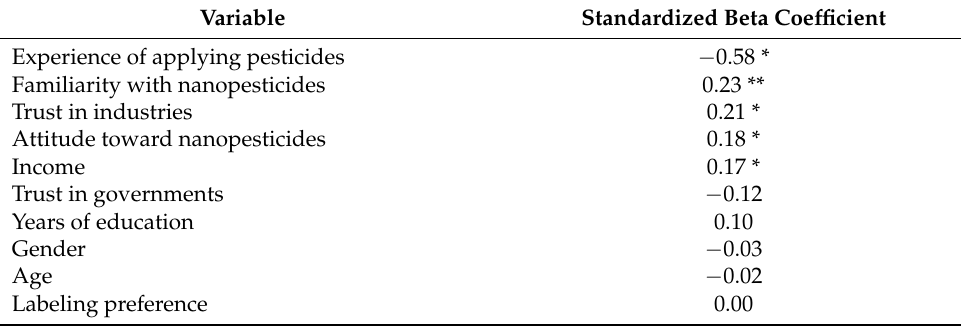
Table A2. Standardized beta coefficients of influencing factors.